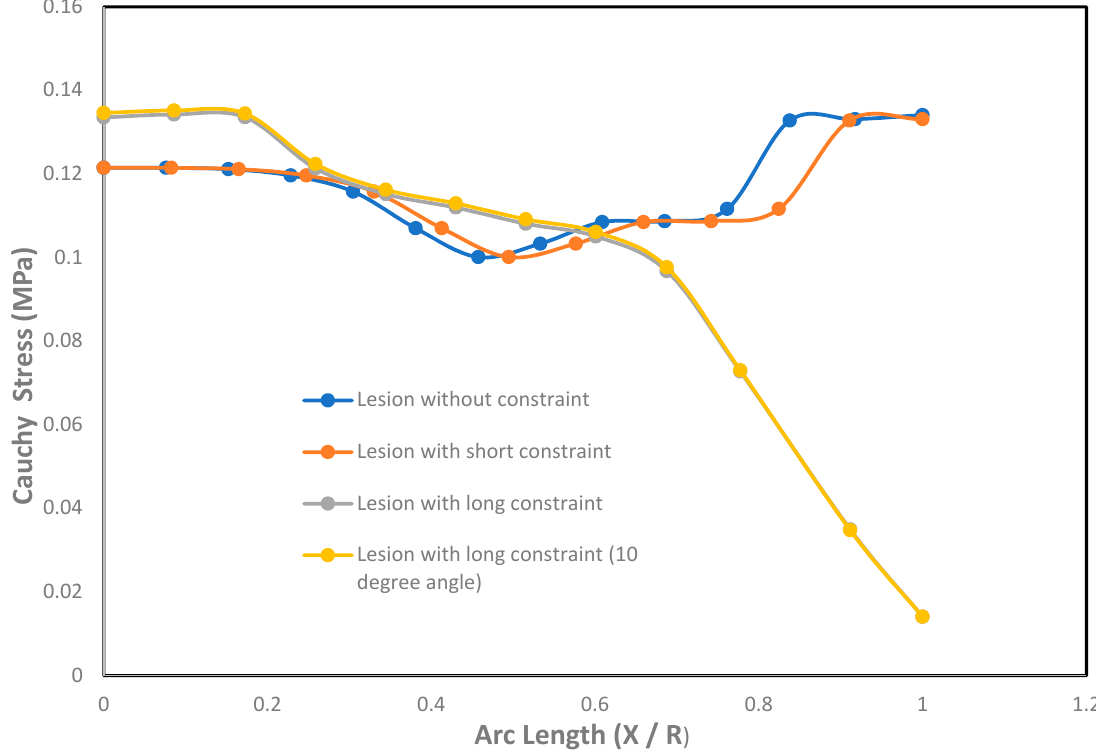
Figure 5. Effect of Cauchy stresses (MPa) with the undeformed arc length (X / R) on the axisymmetric intracranial saccular aneurysm for the cases where lesions without constraints, lesions with short constraints, lesions with long constraints, and lesions with long constraints at an angle of 10 degrees from the horizontal axis. Associated results were shown in both meridional and circumferential directions as a function of nondimensional undeformed arc length (X / R), where X = 0 corresponds to the fundus and X = R corresponds to the neck.